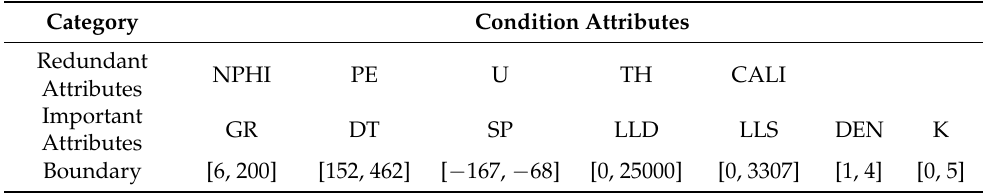
Table 2. Attribute reduction and value range.